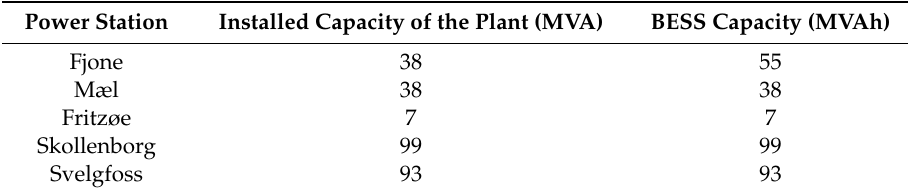
Table 7. Battery installation in the NPS model in the year